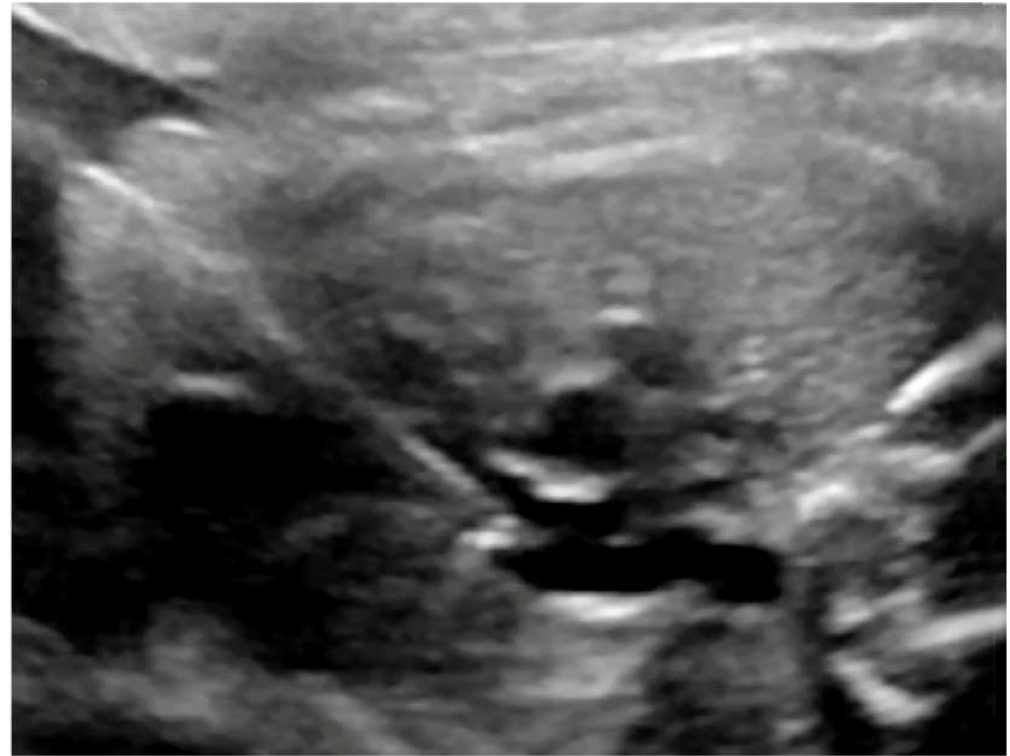
Figure 5. fBPV—the guidewire was introduced through the needle and placed across the pulmonary